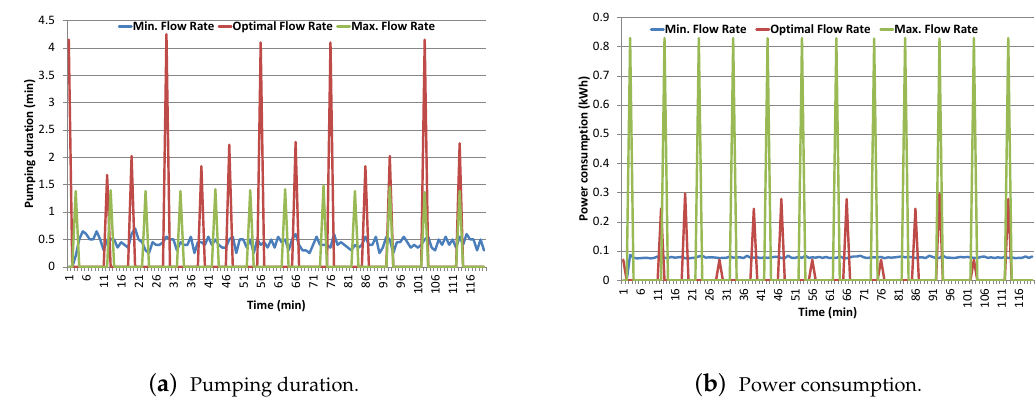
Figure 14. Pumping duration and power consumption results comparison. Table 6. Summary of the comparative